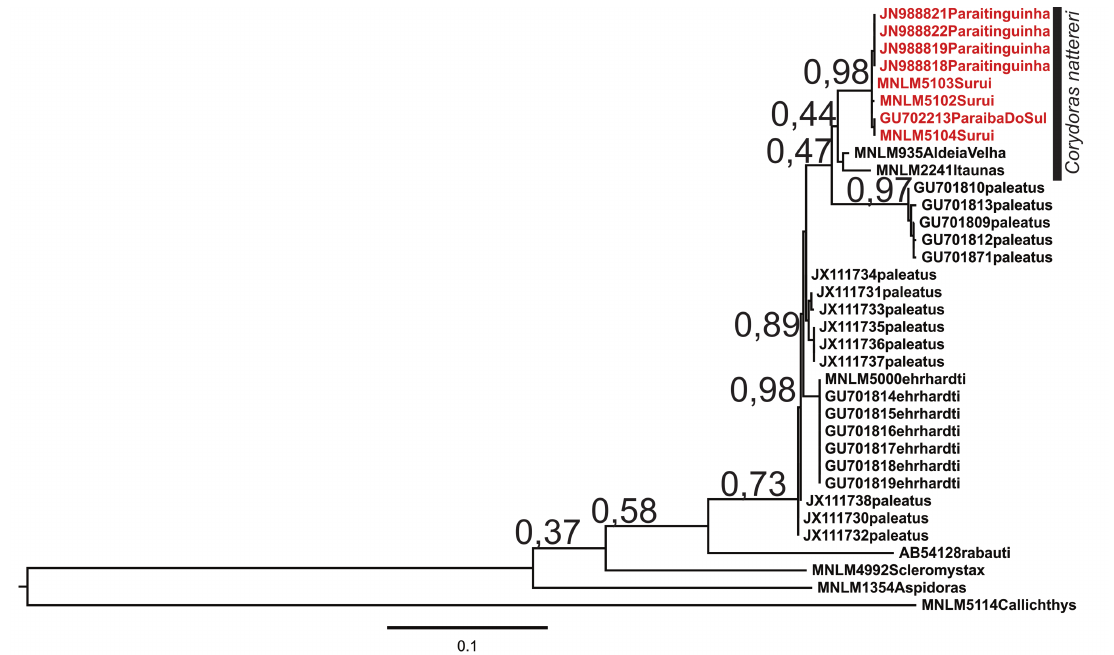
Fig. 3. Maximum likelihood tree (log likelihood = -2410.0522) of Corydoras samples with at least 90% similarity to the mitochondrial cytochrome oxidase I sequences of C. nattereri from the rio Suruí. The tree is drawn to scale, with branch lengths measured in the number of substitutions per site. Bootstrap robustness is indicated next to selected branches. Samples of C. nattereri have the locality name appended to the sample ID (those for which mitogenomes were produced are from de rio “Surui”), outgroups have the genus name and other samples of Corydoras have the species epithet name appended to the ID code (Table